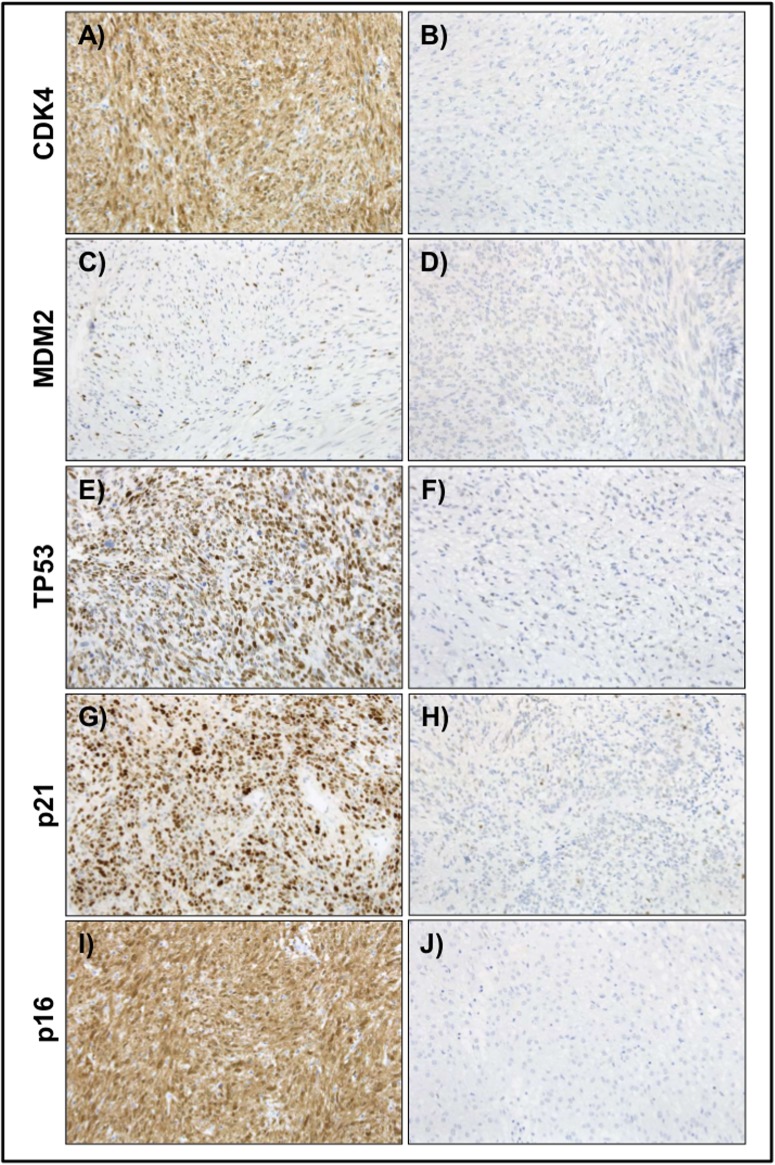
Representative immunohistochemical stainings of CDK4, MDM2,p53, p21 and p16 expression.The expression of different proteins was evaluated by immunohistochemistry. In (A), (C), (E), (G) and (I) the representative high expression pattern of CDK4, MDM2 and p53 (TP53) in different GISTs are shown in contrast to the non/low expression patterns (B), (D), (F), (H) and (J) (100x).